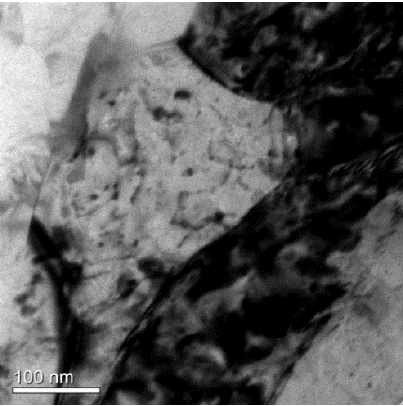
Figure 6. TEM micrograph of as-forged RF50 showing a nano-sized grains with dense dislocation loops. Table 3. EDX Spectrum and Constituted Phases for Dispersoids in Different Samples. (wt.%).